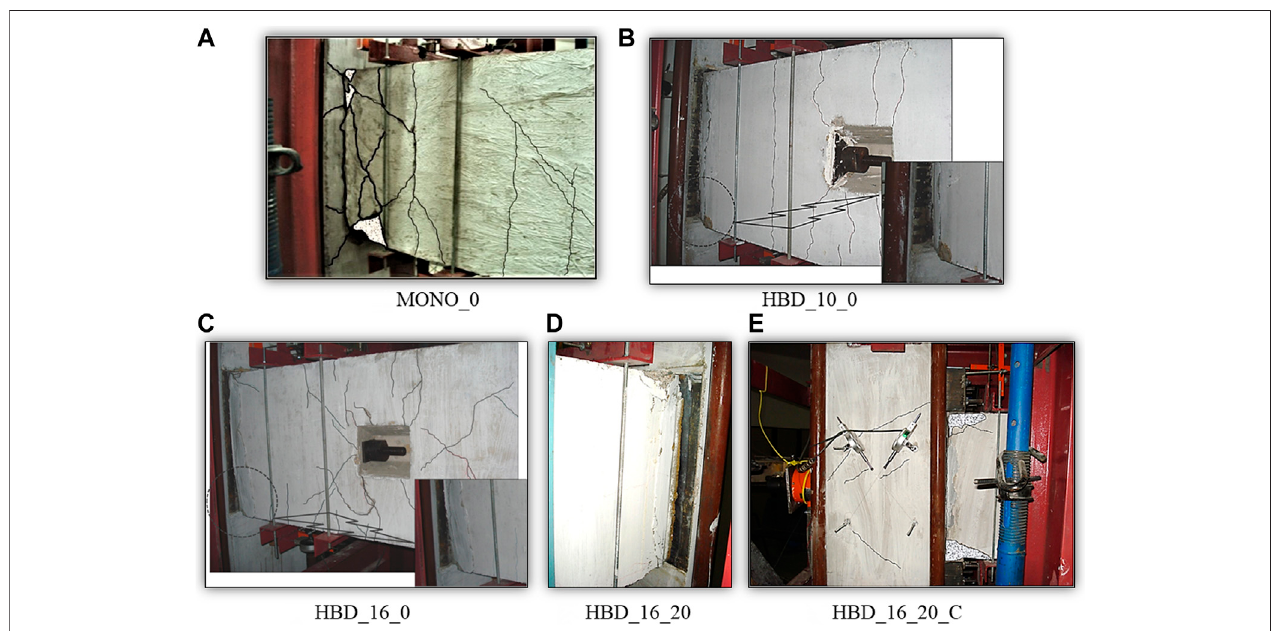
FIGURE 5 | Damage in test specimens at the 4% story drift ratio. (A) MONO_0. (B) HBD_10_0. (C) HBD_16_0. (D) HBD_16_20. (E) HBD_16_20_C.